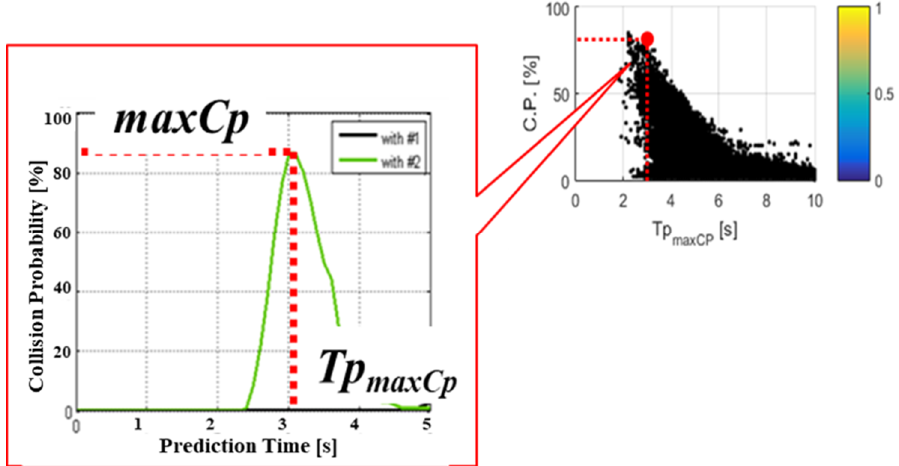
Figure 3. Accumulation of peak collision probability.